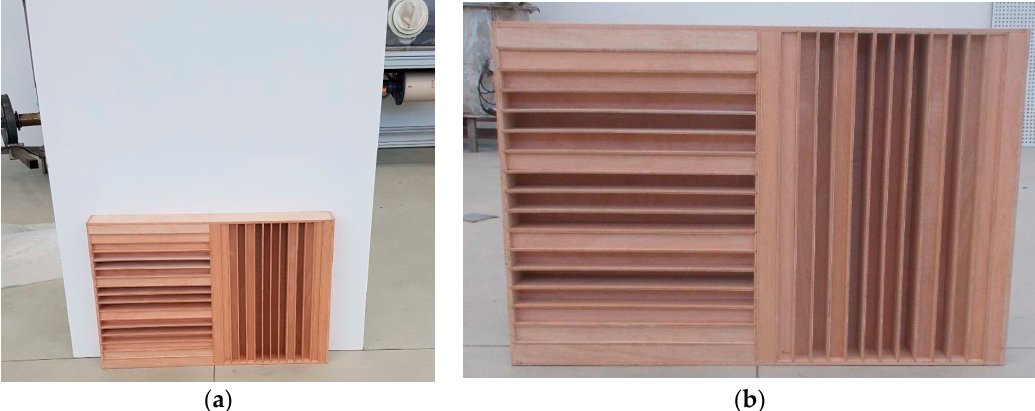
Figure 9. Matching between numerical and experimental data for the horizontal plywood and MDF panels inside Room A at mid-frequencies.